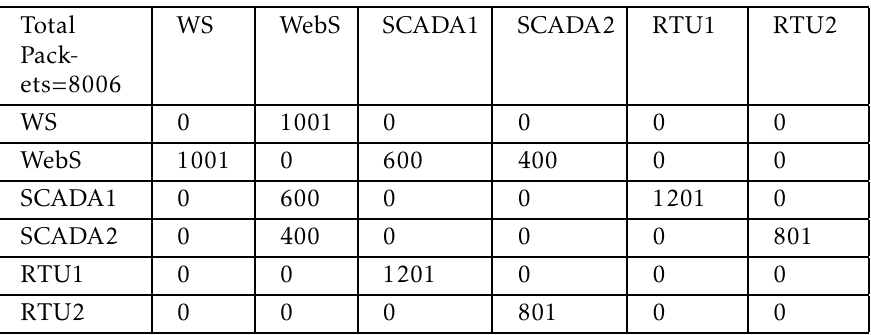
Table 1. Adjacent matrix with bytes.